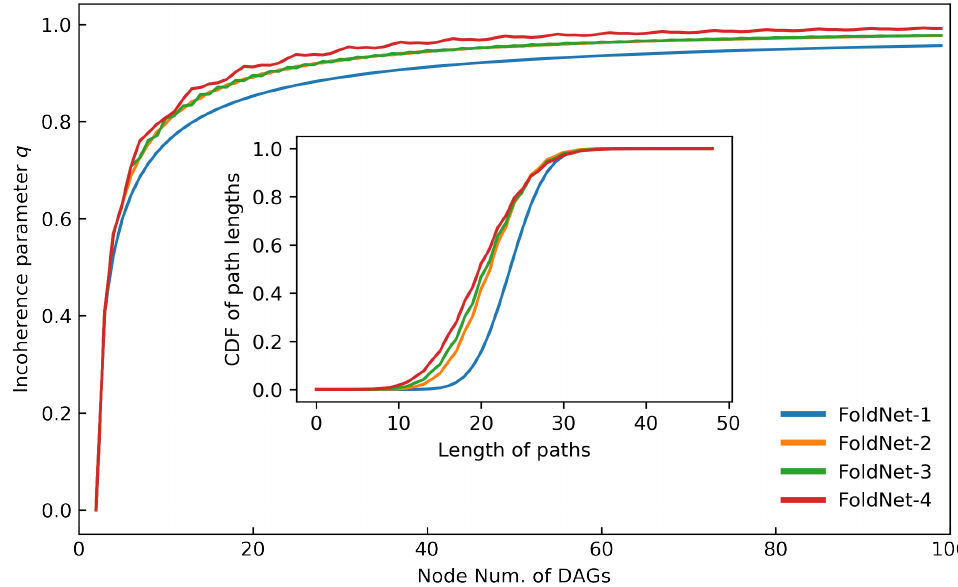
Figure 3. Incoherence and path lengths of DAGs. The main plot illustrates the relationship between incoherence parameter q and number of nodes of DAGs and folding length d . The inset plot shows the relationship between path lengths and folding length d